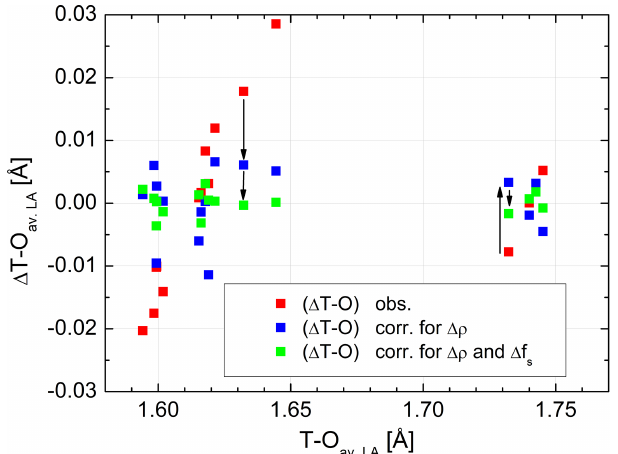
Figure 3. Distance differences (cid:49) T–O [ Å ] ≡ T–O −(cid:104) T–O (cid:105) plotted versus individual T–O distances in average low albite, before and after adjustment. Red squares: observed (cid:49) T–O differences, blue squares: (cid:49) T–O after adjustment for the (cid:49)ρ effect (bond critical point electron densities), green squares: (cid:49) T–O after adjustment for both the (cid:49)ρ and the (cid:49)f s ( O ) effects (fractional s -character of the bridging O atom). For two bonds, T 1 0–O C 0 and T 2 0–O A 2, the ef- fects are visualised by arrows. The sizes of the data points comply with the typical error.